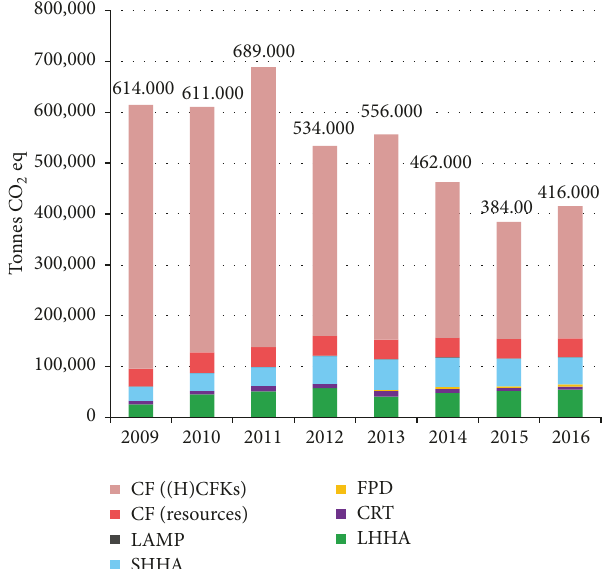
Figure 3: Total avoided CO 2 emissions in tonnes CO 2 -equivalents, per category e-waste, for the period 2009–2016. The contribution of (H)CFKs and raw materials of CFs is presented separately. Numbers are